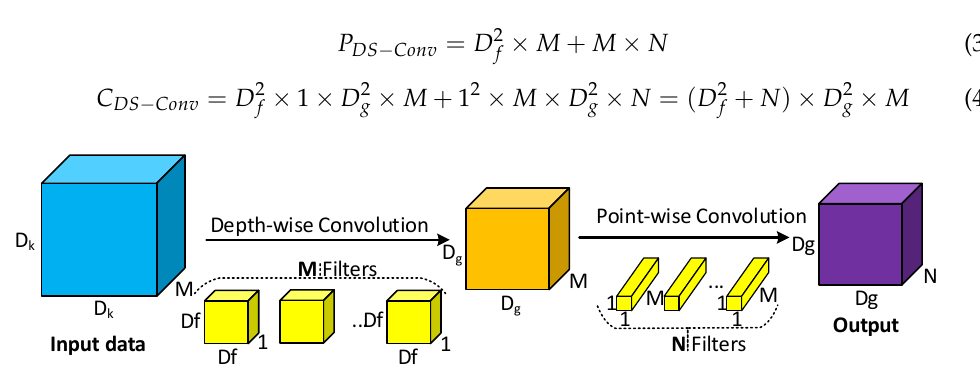
Figure 2. Structure of the depthwise separable convolution